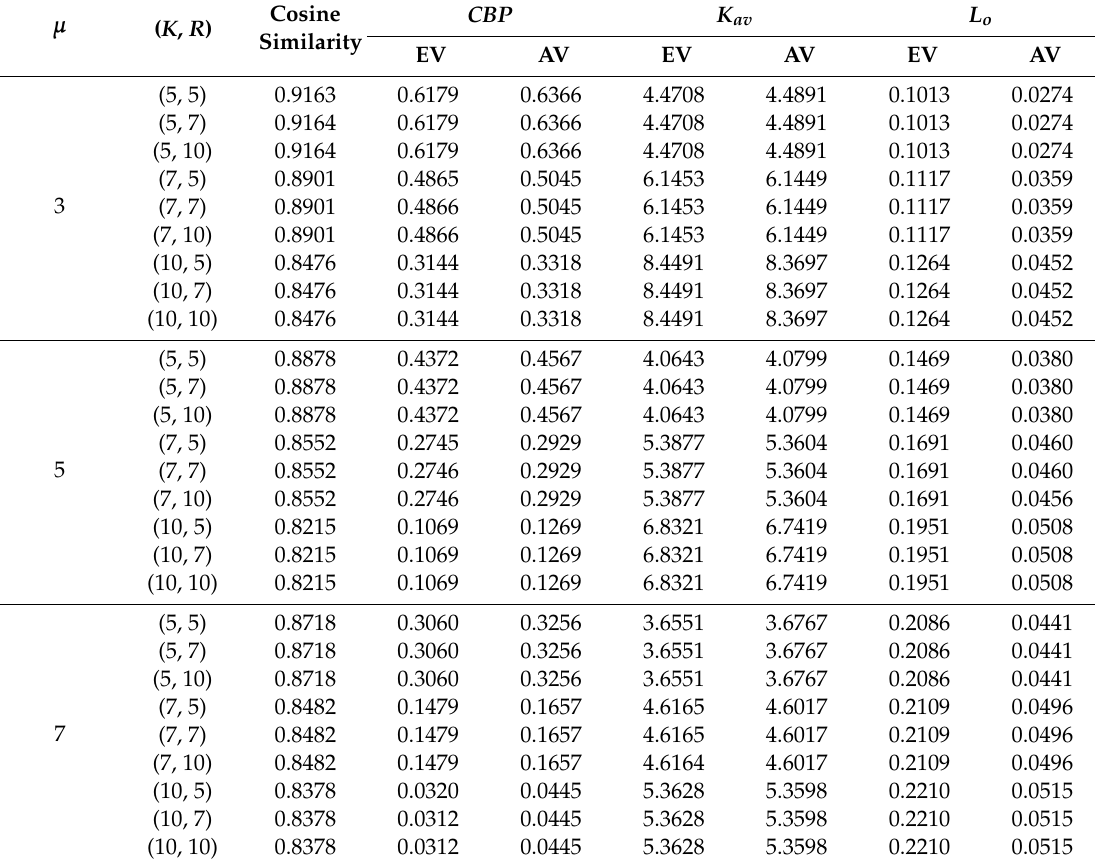
Table 1. Results of numerical experiments, EV—exact values, AV—approximate